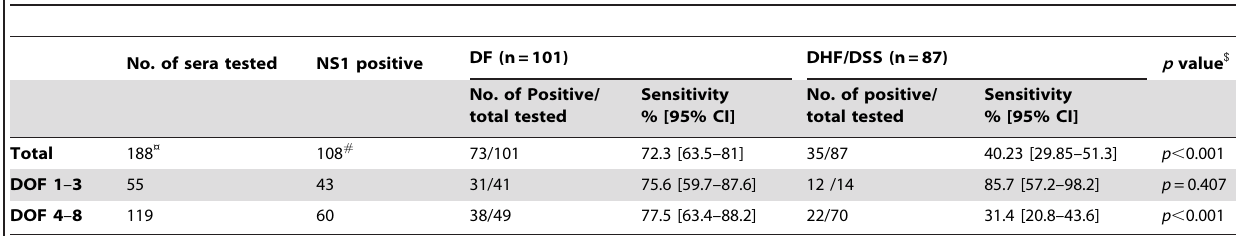
Table 3. Sensitivity of Platelia NS1 assay in DFand DHF/DSS patients according to timing of sample collection after DOF*.